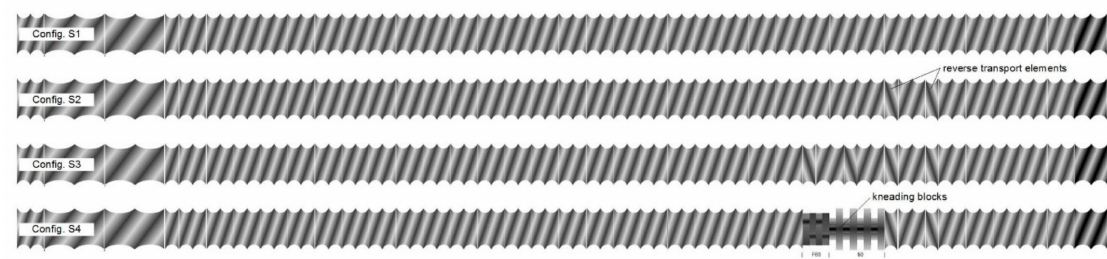
Figure 1. Schematic illustration of all screw configurations used. S1: only transport elements, S2 and S3: two and four reverse elements, S4: two reverse elements and a kneading